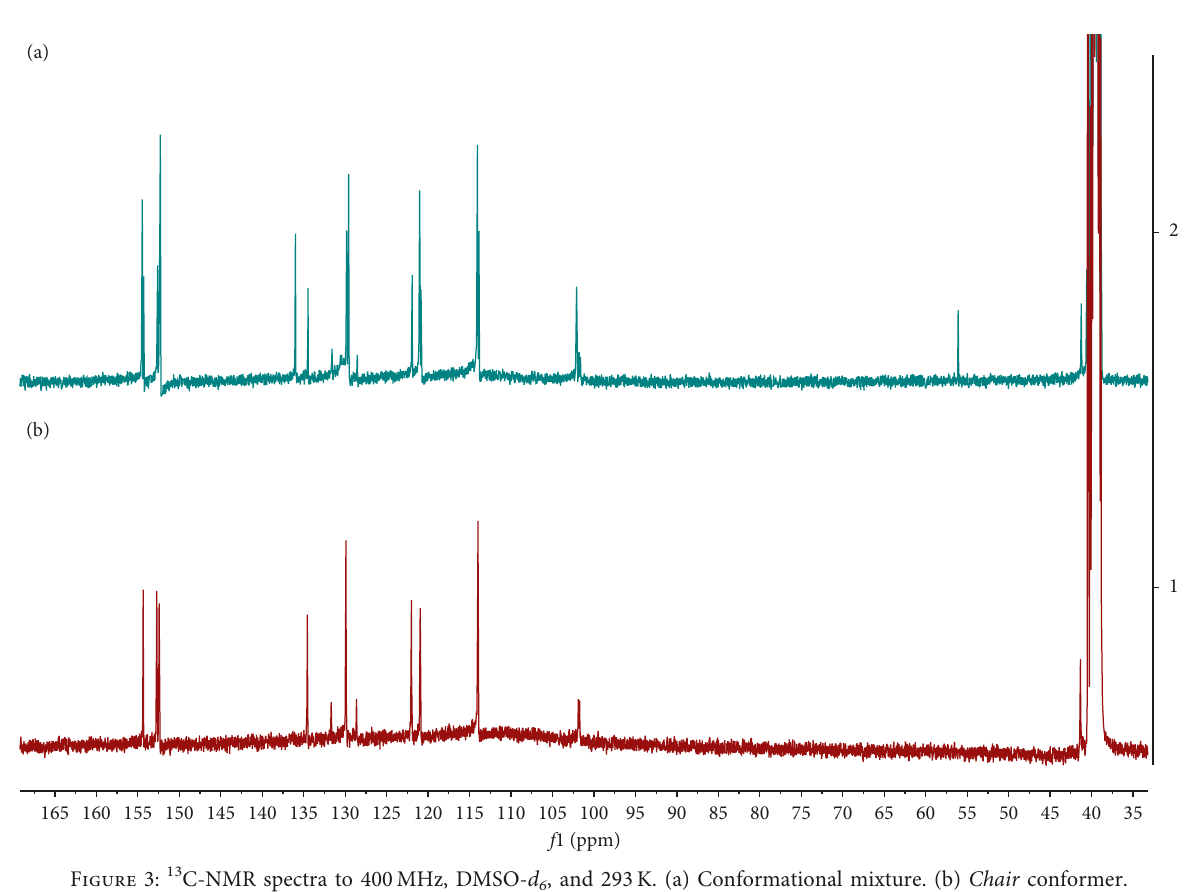
Figure 3: 13 C-NMR spectra to 400 MHz, DMSO- d 6 , and 293K. (a) Conformational mixture. (b) Chair conformer.